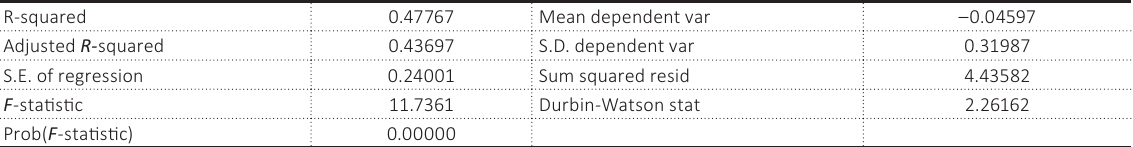
Table A6. Autocorrelation test